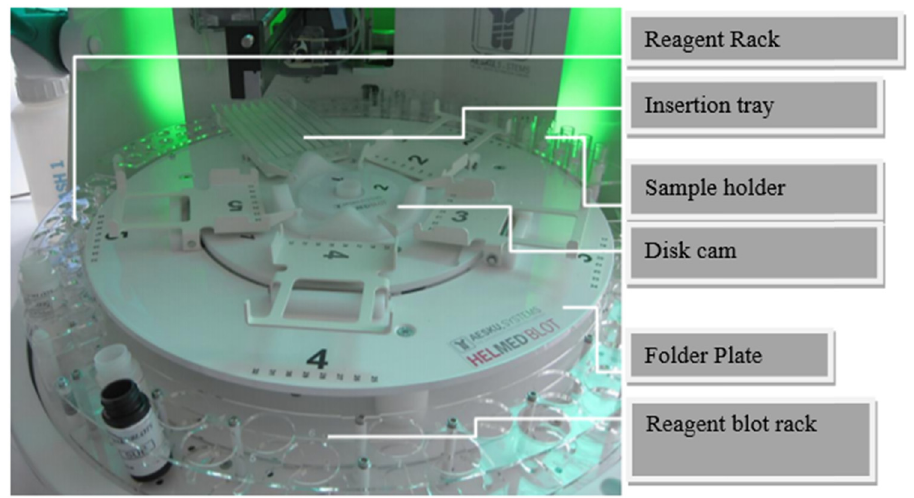
Figure 1: Immunoblot image ( Blot - 17, HELMED ) .